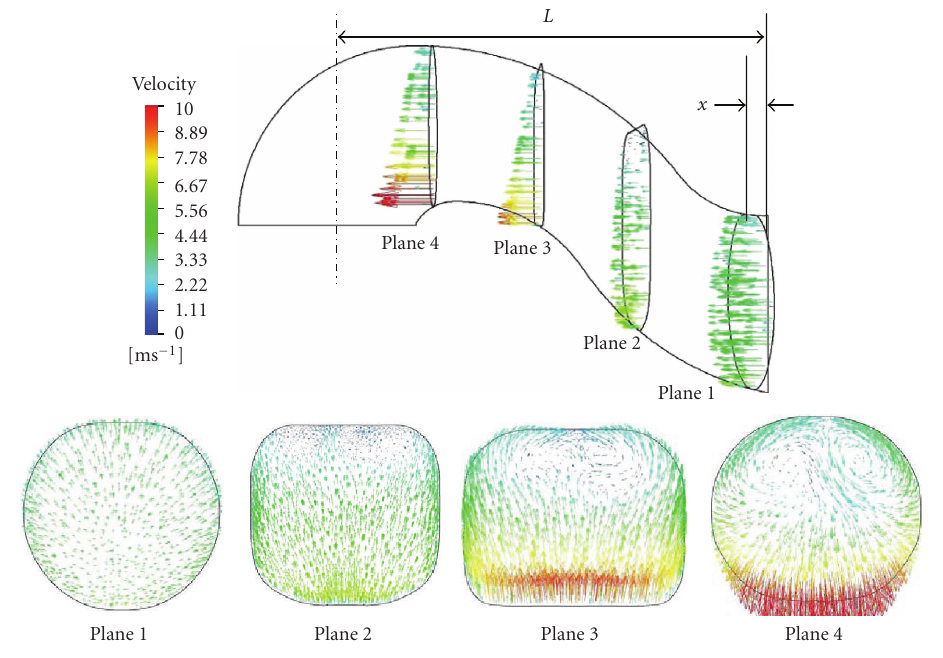
Figure 4: Flow separation in intake section at various